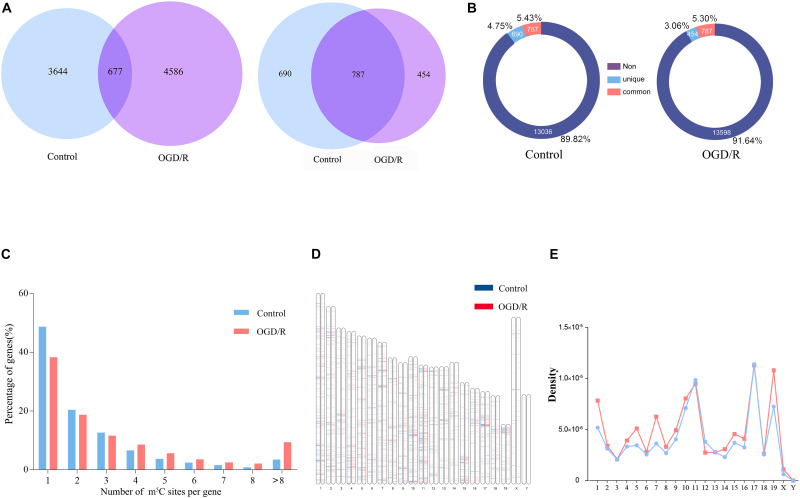
Overview of the mRNA m5C profiles in the control group and OGD/R group and verification of methylation targeting. (A) The overlap of the mRNA m5C sites (left) and genes methylated with the m5C site (right) between the control group and the OGD/R group. (B) Analysis of the proportion of m5C-modified genes. Non, genes with no methylation site; unique, the methylation sites only exist in the genes of OGD/R group or the control group; common, the methylation sites exist in the genes of both groups (C) Bar chart presenting the numbers of mRNA m5C sites per gene. (D) Visualization of the m5C sites at the chromosome level in the control group and OGD/R group. (E) Line graph presenting the density of m5C sites in each chromosome.